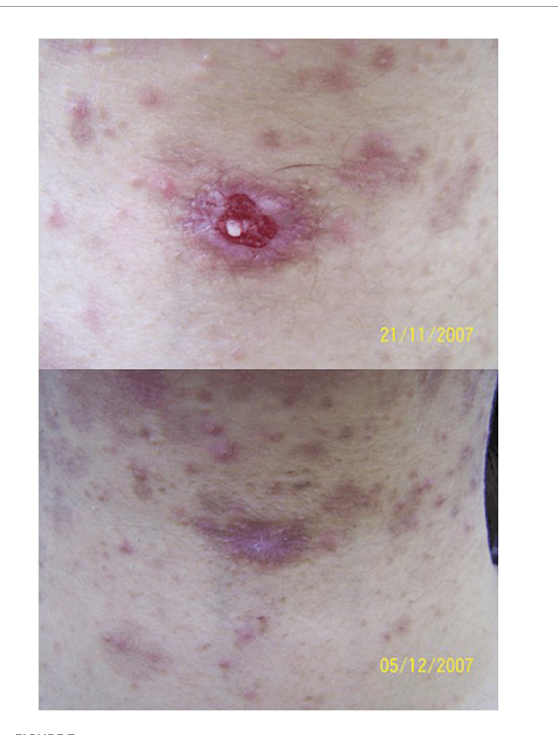
FIGURE7 Methyl aminolaevulinate-photodynamic therapy (MAL-PDT) for recalcitrant ulcer in pemphigus vulgaris. Up: recalcitrant ulceration on the cervical region in a patient with pemphigus vulgaris. Down: complete closure of the ulceration 1 week after two sessions of MAL-PDT (figure adapted from the reference 118 with permission of John Wiley and